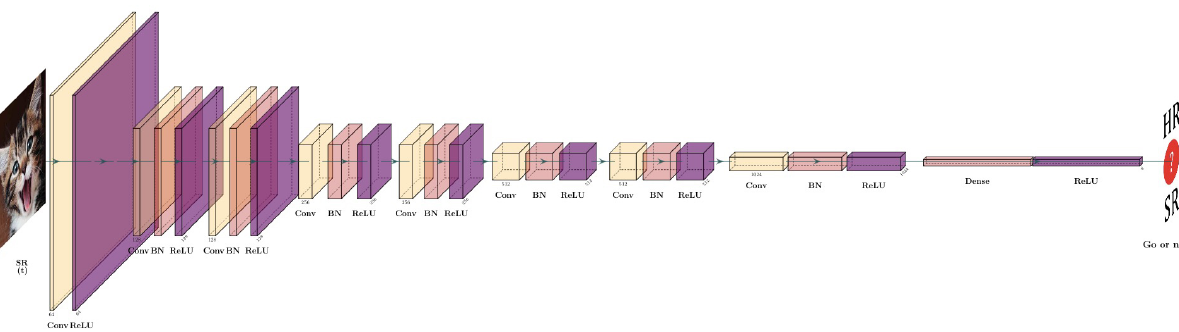
Fig. 5 Discriminator architecture from SRGAN [20]. The discriminator uses Leaky ReLUs for computing its activations.